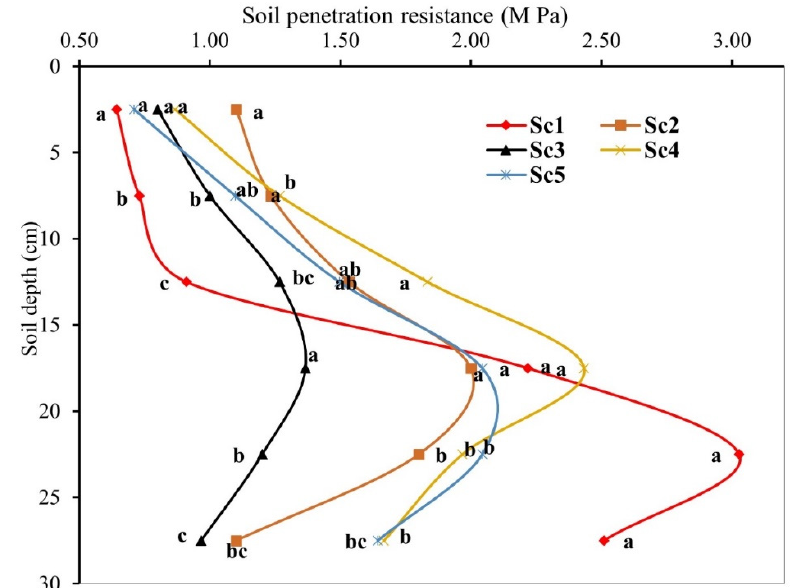
Figure 2. Soil penetration resistance (MPa) as influenced by CSA-based crop management practices. Values with a similar lowercase letter (s) with in each soil depth are not significantly different at 0.05 level of probability using Tukey’s HSD test. (for a detailed description of scenarios refer to Table 1).